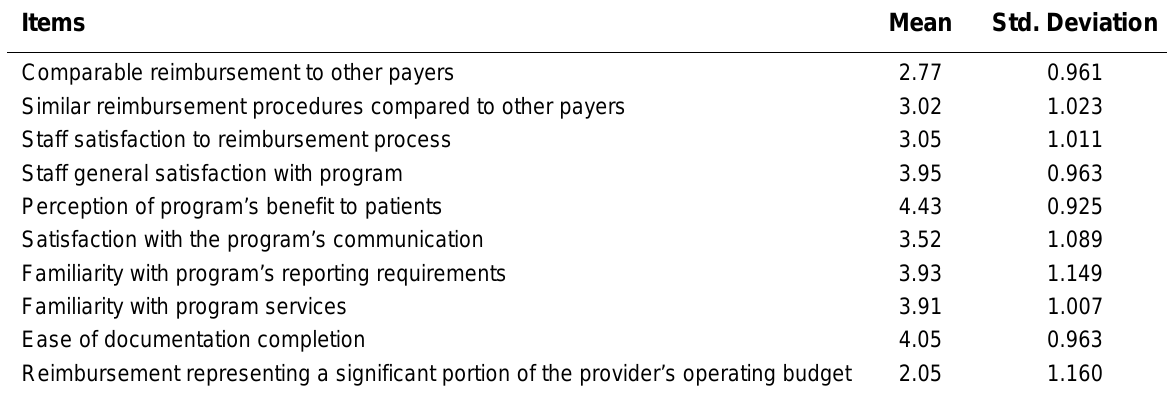
Means and Standard Deviation of Items for Provider Satisfaction